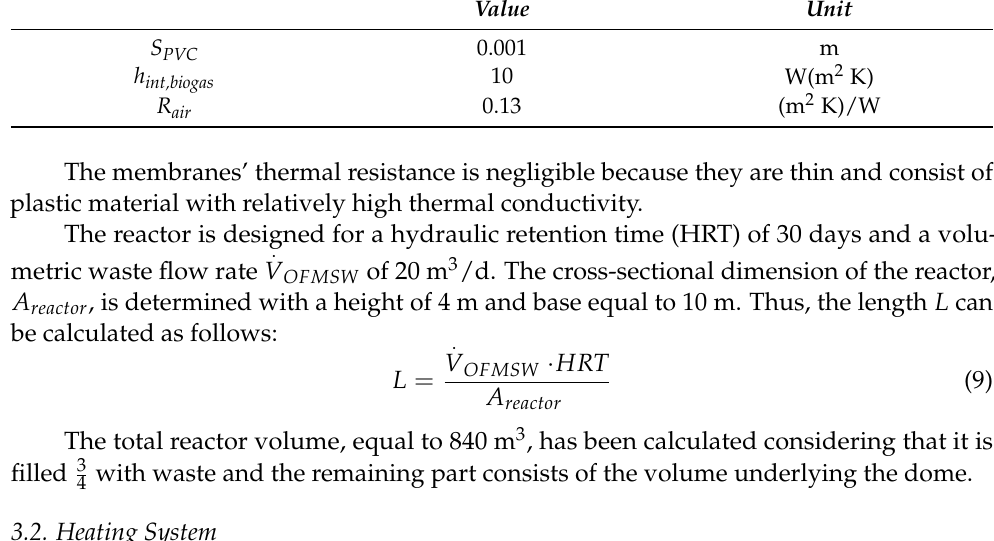
Table 5. Gasometric dome structural and thermal parameters. Value